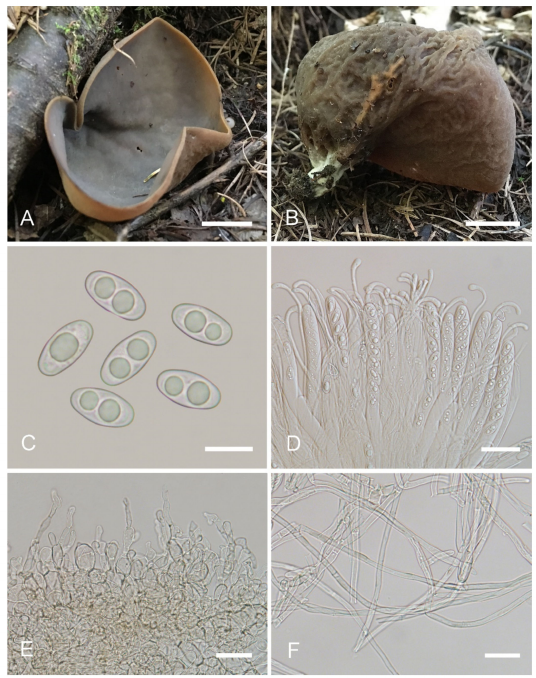
Figure 8. Otidea plicara (BJTC FM262-A) ( A , B ) apothecia, ( C ) ascospores, ( D ) paraphyses and asci, ( E ) ectal excipulum in water, and ( F ) basal mycelium. Scale bars: ( A , B ) = 1 cm, ( C ) = 10 µ m, ( D , E ) = 30 µ m, ( F ) = 20 µ